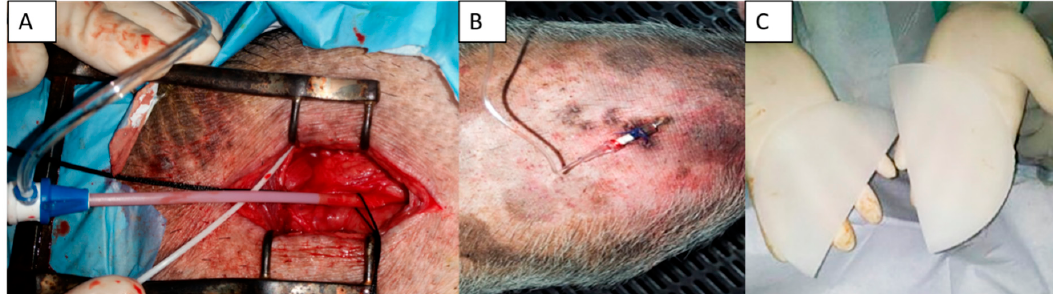
Figure 2. ( A , B ) The arterial blood pressure catheter was placed in all swine and subcutaneously tunneled out for easy access and monitoring; ( C ) Silicon-based 11-deoxycorticosterone implants that were placed in all swine for the creation of the hypertension model.